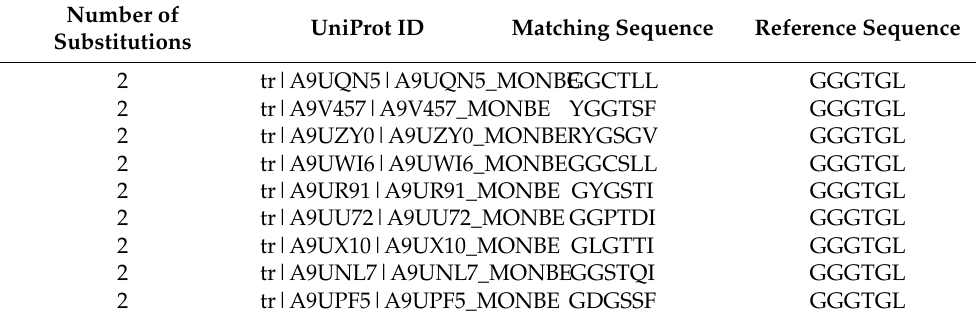
Table 5. Example output of Motif Matcher, using sequence GGGTGL as a search